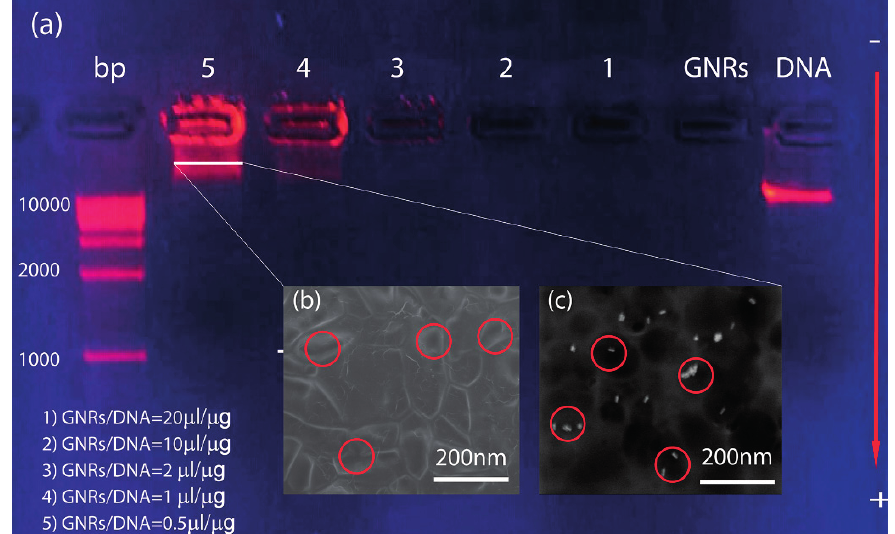
Figure 3. Gel electrophoresis ( a ) along with the environmental scanning electron microscope (ESEM) cross section of the line 5 of agarose matrix before (without the GNRs/DNA solution) ( b ) and after (with the GNRs/DNA solution) the electrophoretic run ( c